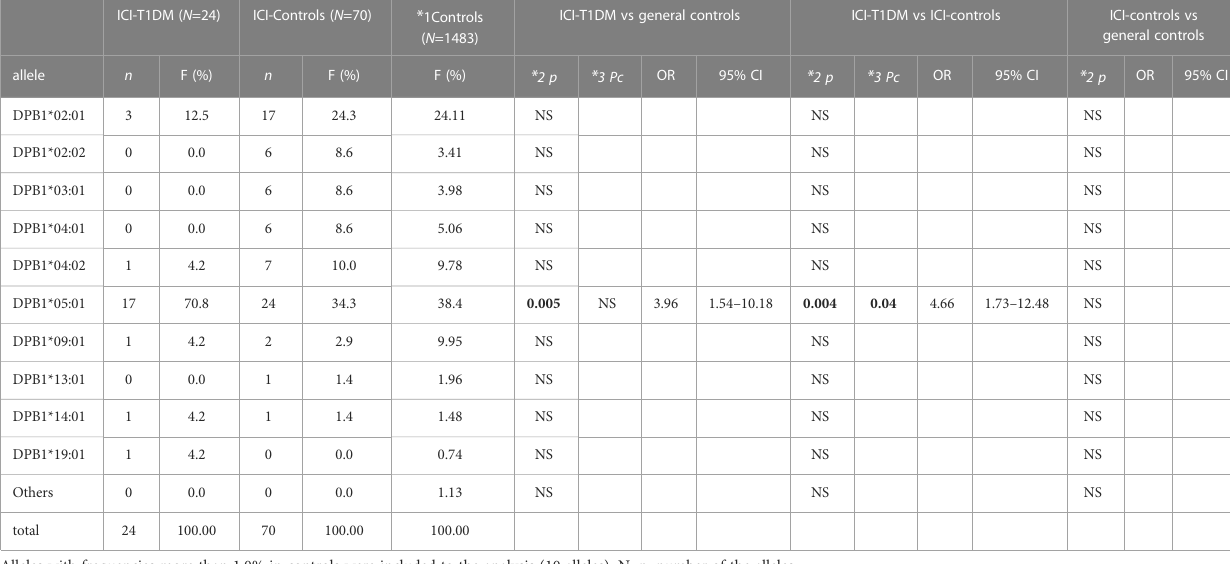
TABLE 2C Allele frequencies of HLA-DPB1 in patients with ICI-T1DM and controls. ICI-T1DM ( N